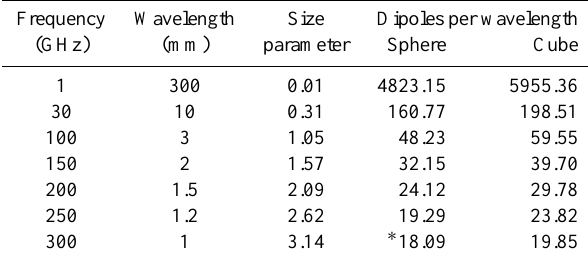
Table 1. Size parameter and number of dipoles per wavelength for the modeled sphere and cube for selected